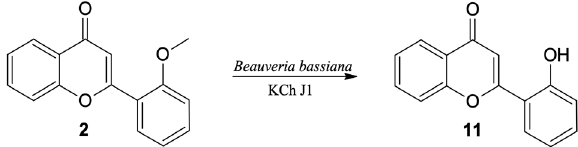
Figure 3. Biotransformation of 3 ′ -methoxyflavone ( 2 ) by B. bassiana KCh J1.